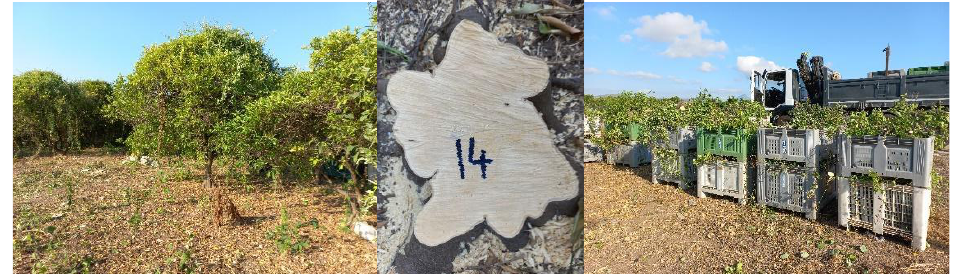
Figure 1. Measuring, cutting down, and weighing process of tress .